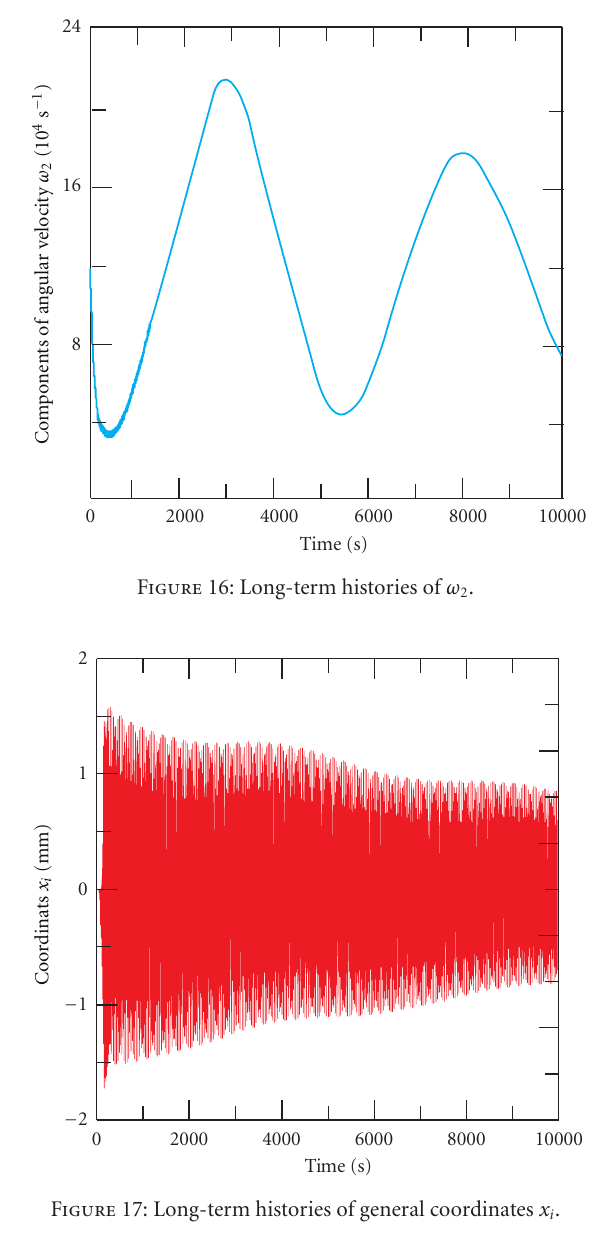
Figure 17: Long-term histories of general coordinates x i .